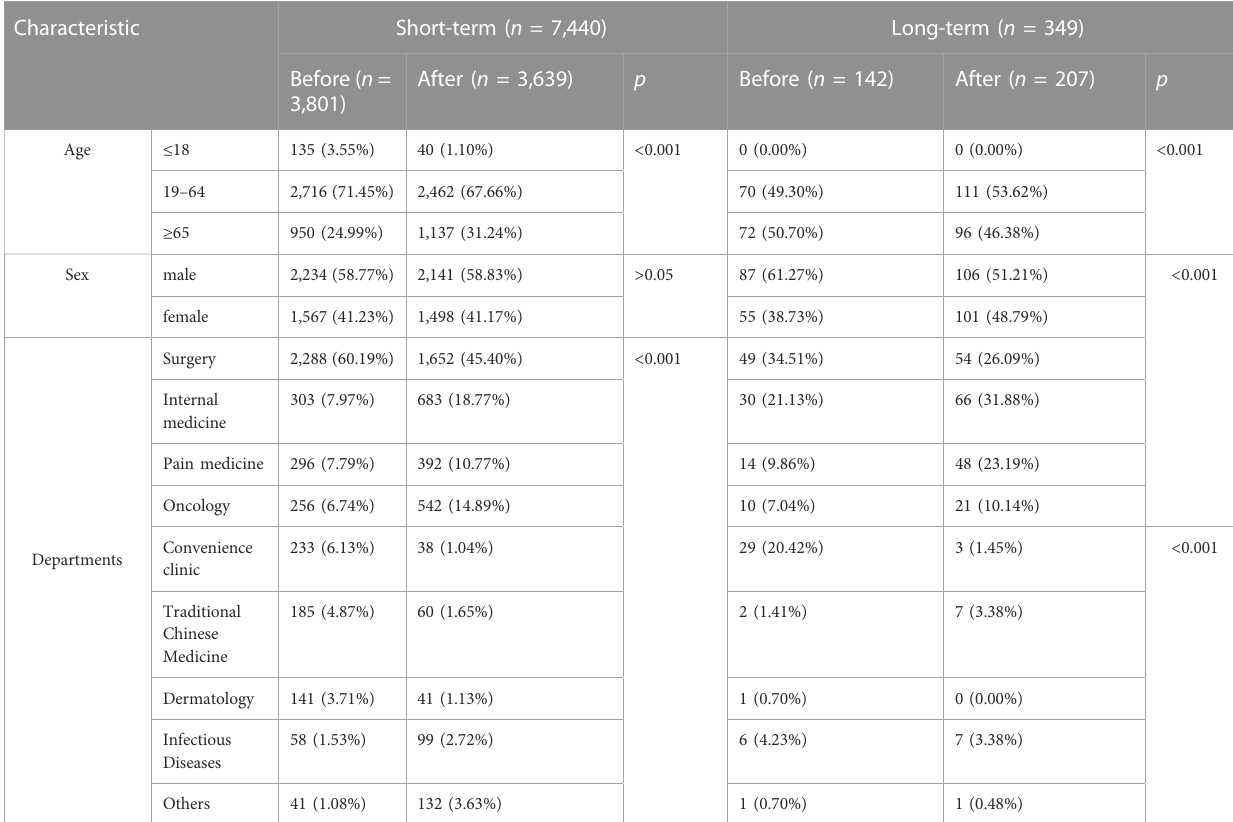
TABLE 1 Demographic and clinical characteristics of the short-term and long-term drug users before and after the policy.